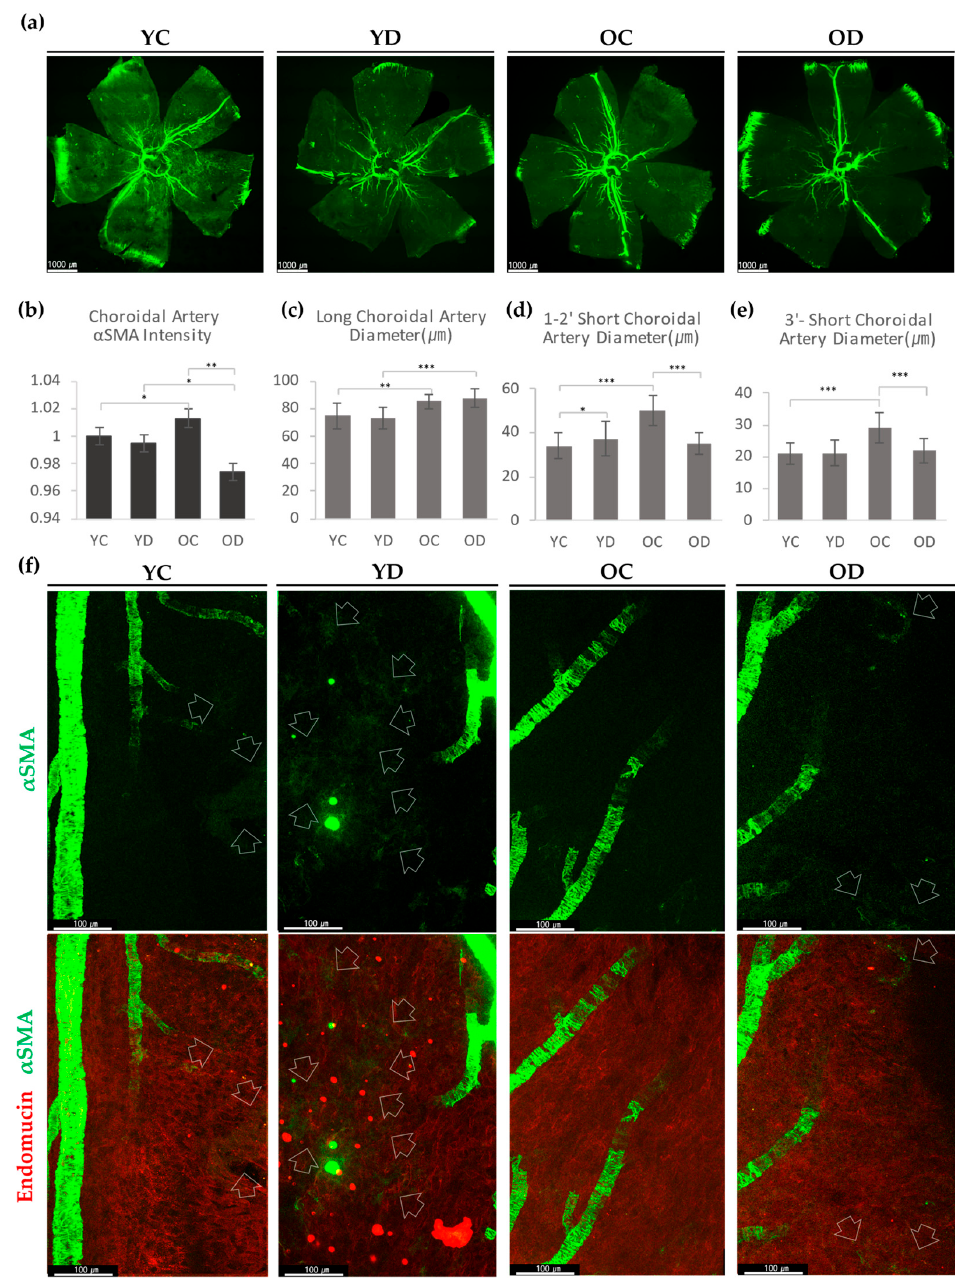
Figure 5. α SMA expression of the diabetic choroid. ( a ) Representative choroidal wholemount images from Young Control (YC), Young Diabetes (YD), Old Control (OC), and Old Diabetes (OD). ( b ) Quantification of relative fluorescence intensity of choroid arterial α SMA. ( c ) The diameter of the long choroidal artery that traverses from central to the far-peripheral edge. Diameters were measured at 8 points per each sample. ( d ) The diameter of 1st and 2nd order short choroidal artery. Diameters were measured at 15 points per each sample. ( e ) The diameter of the 3rd order or higher short choroidal artery. Diameters were measured at 20 points per each sample. ( f ) YD showed remarkably increased α SMA expression at choriocapillaris than YC. OC choroid hardly showed capillary α SMA, where OD revealed α SMA in choriocapillaris but greatly reduced from YD. Arrows indicate the expression of α SMA at choriocapillaris. ( b – e ) 4 different samples were analyzed and averaged per condition. Error bars indicate SD. (Student’s t -test; N (b) = 16, N (c) = 32, N (d) = 60, N (e) = 80 per group; * p < 0.05, ** p < 0.01, *** p < 0.001).